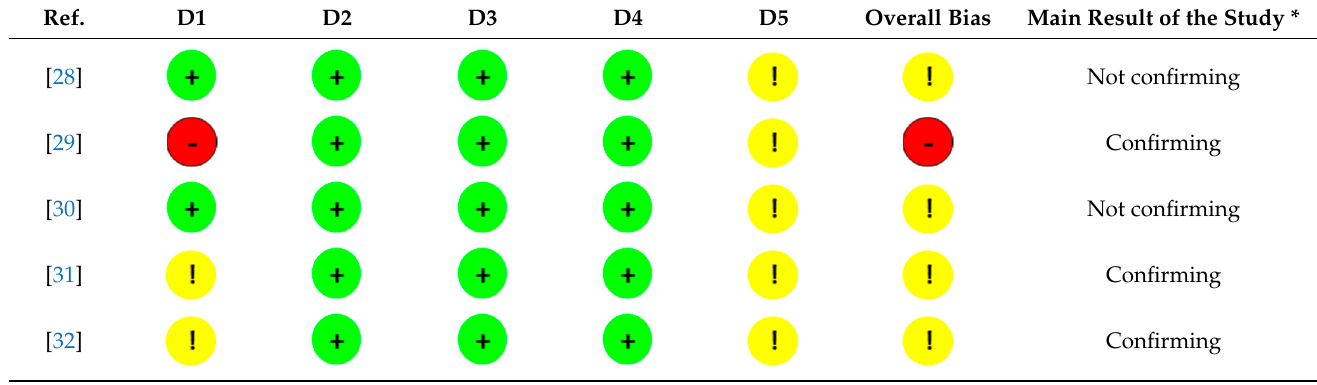
Table 5. The risk of bias assessments for studies, conducted using the revised Cochrane risk-of-bias tool for randomized trials, accompanied by the main results of the studies included in the systematic review. —Low risk; —Some concerns —High risk; * the summary of conclusions defined as con- firming (if confirming a positive influence of vitamin D supplementation on mental health) or not confirming (if not confirming a positive influence of vitamin D supplementation on mental health); domains of risk of bias: D1—arising from the randomization process; D2—due to deviations from the intended interventions; D3—due to missing outcome data; D4—in measurement of the outcome; D5—in the selection of the reported results.